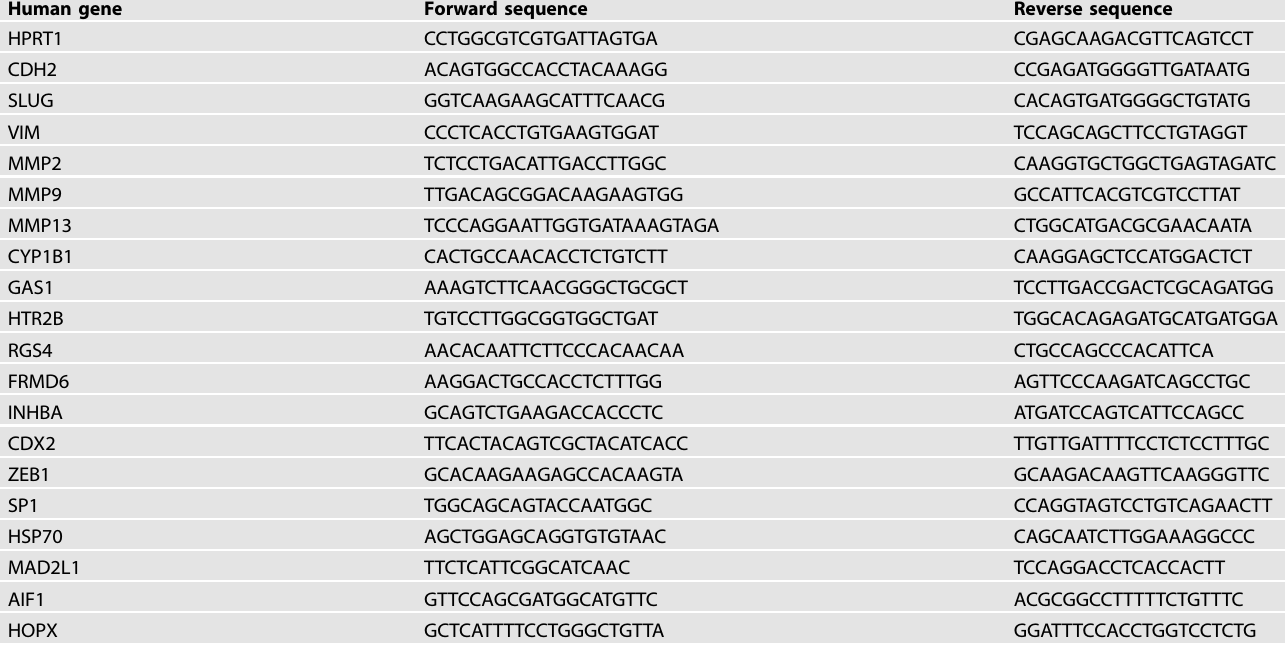
Table 1. RT-qPCR primers